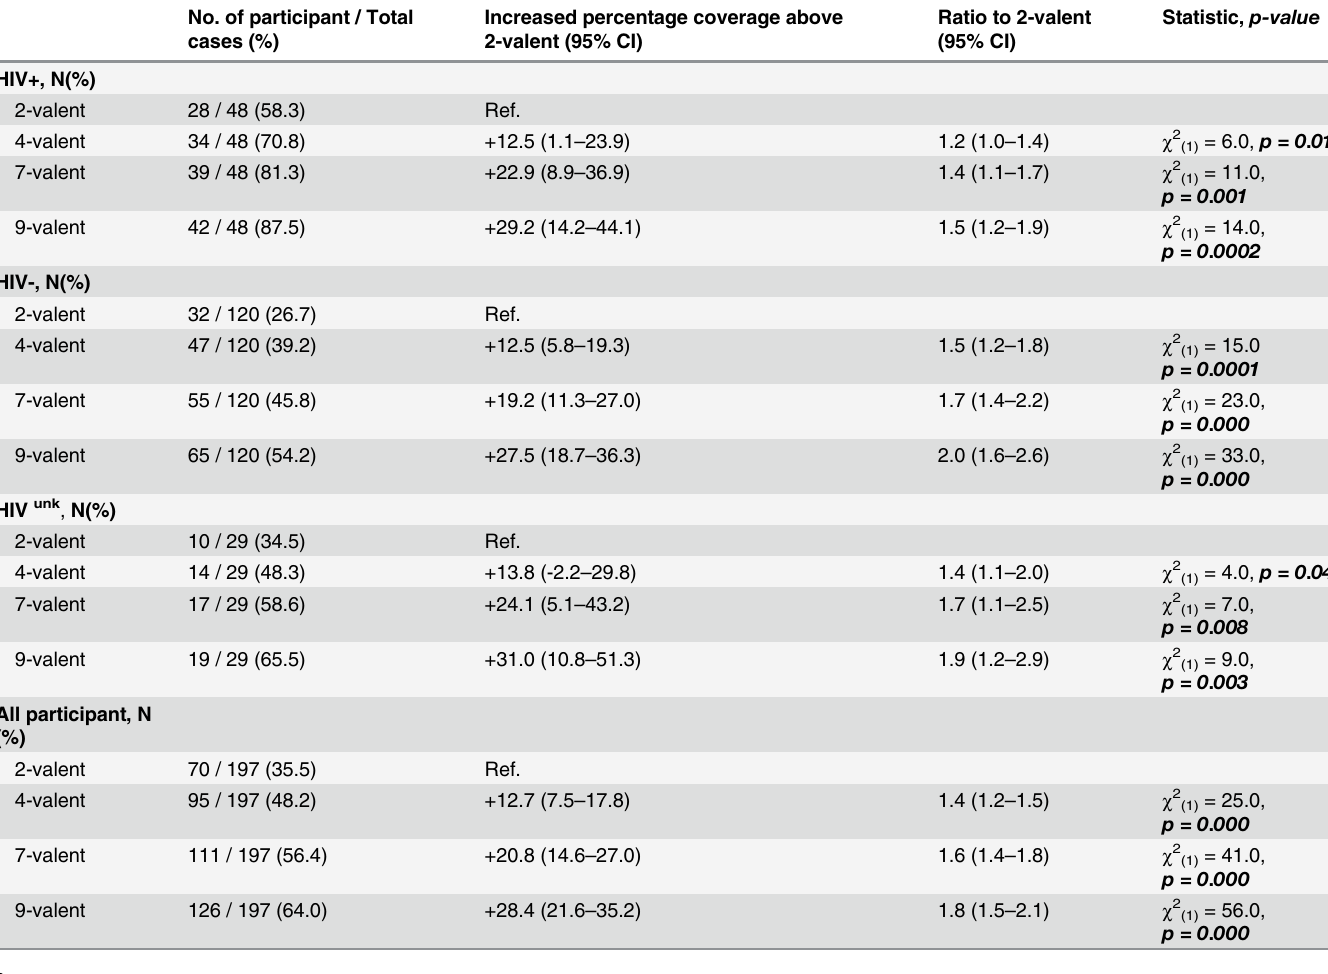
Table 5. Coverage by commercial a , b and investigational c , d HPV vaccines of (cid:1) 1 HPV infecting type(s), by HIV status of MSM subjects in Chiang Mai, Thailand, 2012 – 2013. No. of participant / Total cases